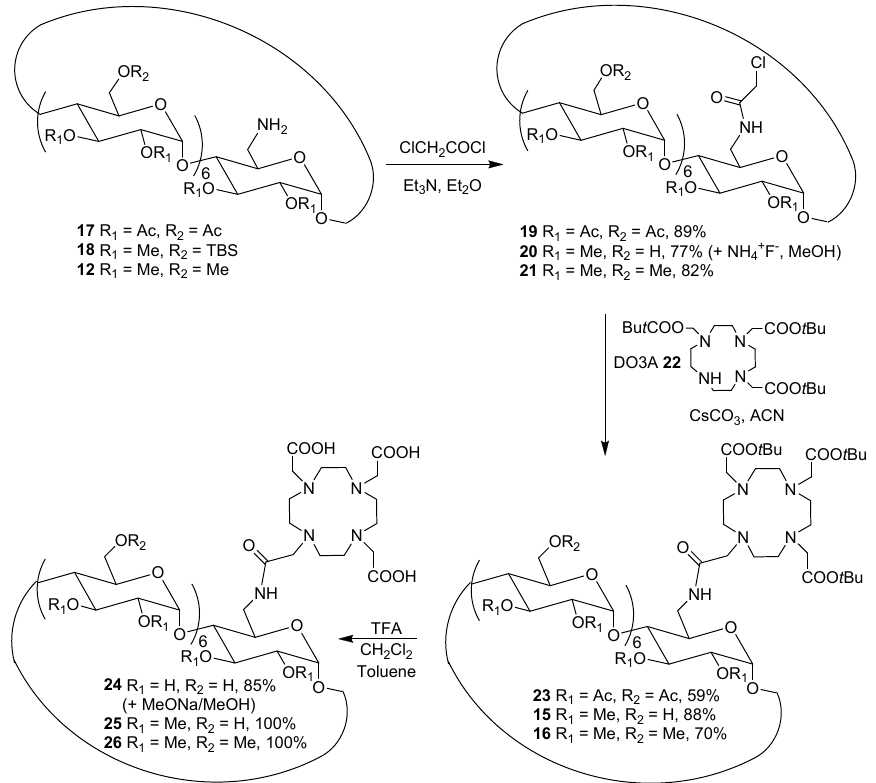
Scheme 2. Second strategy to the synthesis of β -CDs-DOTAMA ligands 24 – 26 .